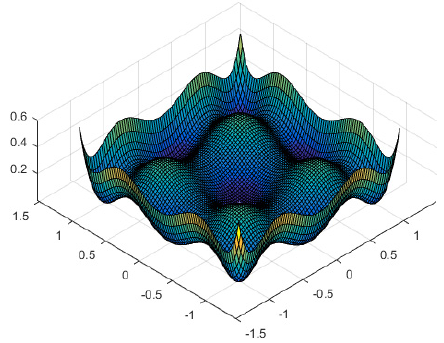
Figure 1. Graph of ALLAWI test function for d = 2 and ε = 2.22 × 10 − 16 .